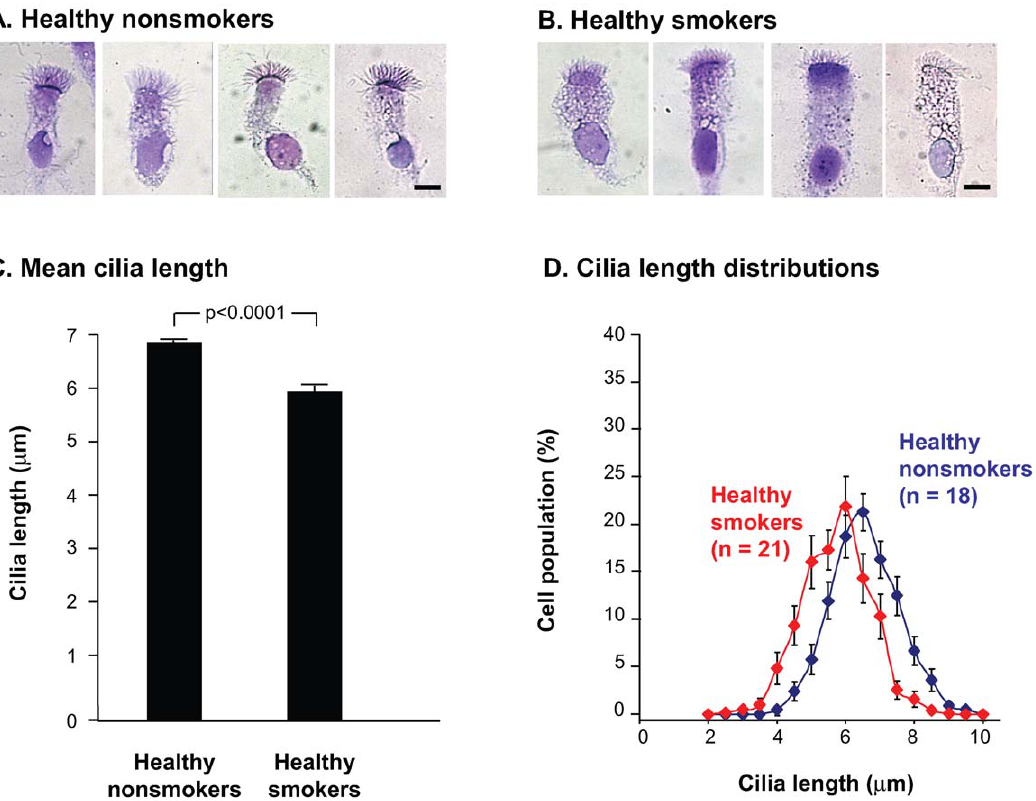
Figure 2. Cilia length in normal smokers and nonsmokers measured in air-dried, un-fixed samples. Suspensions of airway epithelial cells were applied to glass slides using a cytocentrifuge, air-dried, and stained with Diff-Quik. (A) Ciliated airway epithelial cell morphology in normal nonsmokers. Bar =10 m. (B) Ciliated airway epithelial cell morphology in normal smokers. Bar =10 m. (C) Quantitative assessment of cilia length of normal nonsmokers and normal smokers. Shown are the mean standard error of cilia lengths for nonsmokers (n=18) and smokers (n=21). Between 19 and 60 individual measurements were made per study individual (median =27). (D) Distribution of cilia lengths in airway epithelial cells from normal nonsmokers and normal smokers. Distributions were constructed by creating histograms from 0.5 micron bins and then equally weighting each study